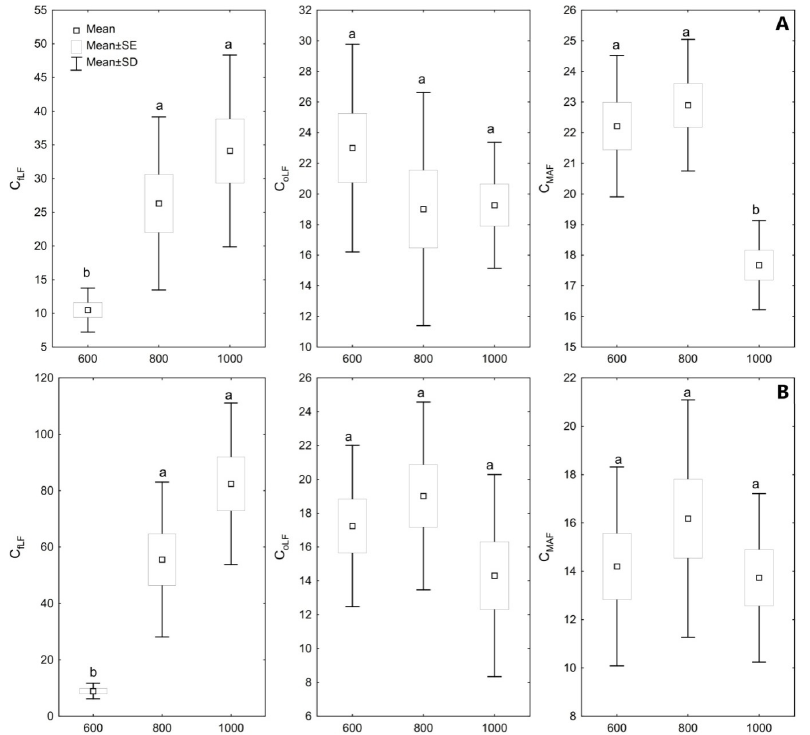
Figure 1. Carbon of different fraction of soil organic matter in soils under influence of different forest stands in altitude gradient (CfLF—carbon of free light fraction (g kg − 1 ), CoLF—carbon of occluded light fraction (g kg − 1 ), CMAF—carbon of mineral associated fraction (g kg − 1 ); ( A )—soils under influence of beech, ( B )—soils under influence of fir; small letters mean significant differences in altitude gradient (a, b)).